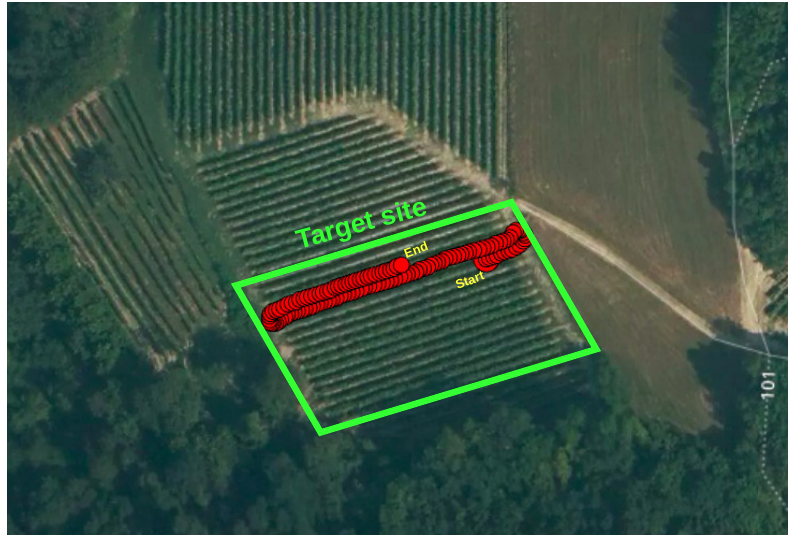
Figure 4. Italy’s target site in green; studied path in red and its start and end locations in yellow.